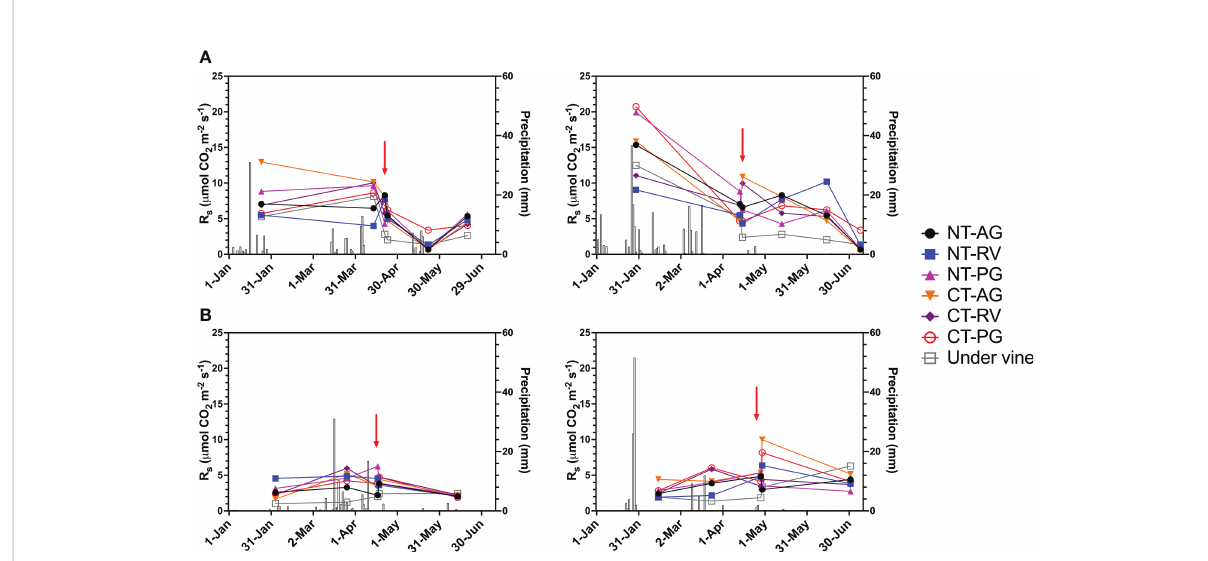
FIGURE 2 Progression of soil respiration (R s ) and daily precipitation amounts in two wine grape vineyards, (A) Oakville, CA; (B) Five Points, CA; 1) 2020; 2) 2021. AG, annual grass; PG, perennial grass; RV, resident vegetation; CT, conventional tillage; NT, no-till. Red arrows indicate tillage for CT treatments.